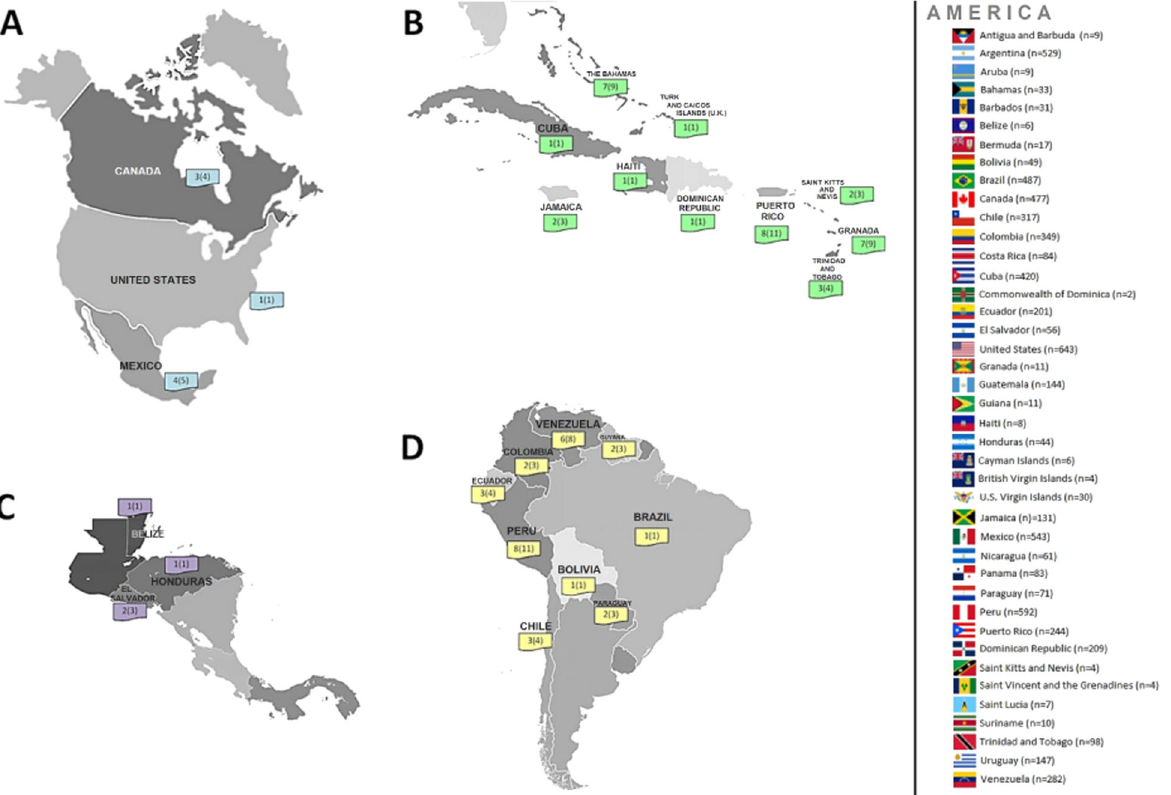
Fig. 1 Demographic distribution of athletes with oral problems during the JPL-19. The map shows the number of cases according to different geographical regions including North ( A ) and South America ( D ), and Central America ( B ) and Caribbean ( C ). The percentages of total reported cases are in brackets. The “ n ” in the legend represents the total of athletes per